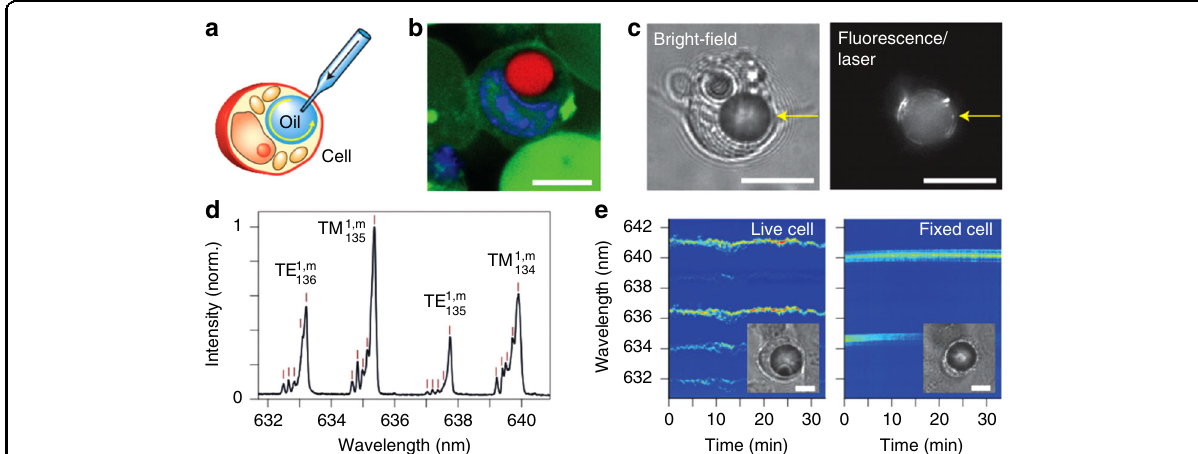
Fig. 5 Illustration and microscopic images of the procedure followed to obtain oil microdroplets within single cells. a Schematic diagram of the injection of a PPE droplet into the cytoplasm of a cell. b Confocal fl uorescence image of a cell containing a PPE droplet doped with Nile red dye (red). The nucleus of the cell can be seen in blue. c Bright- fi eld (left) and laser output (right) images of a cell containing a PPE droplet. d Typical output spectrum of the lasing modes. e Time-lapse variation in the output spectrum for a live cell (left) and a dead cell fi xed with formaldehyde (right). Adapted from ref.